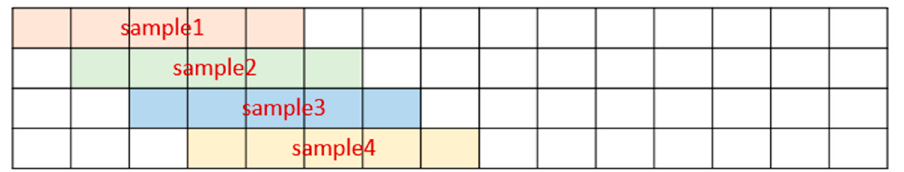
Figure 10. An example illustration of generating training samples and validation samples for data augmentation (n_steps = 5).